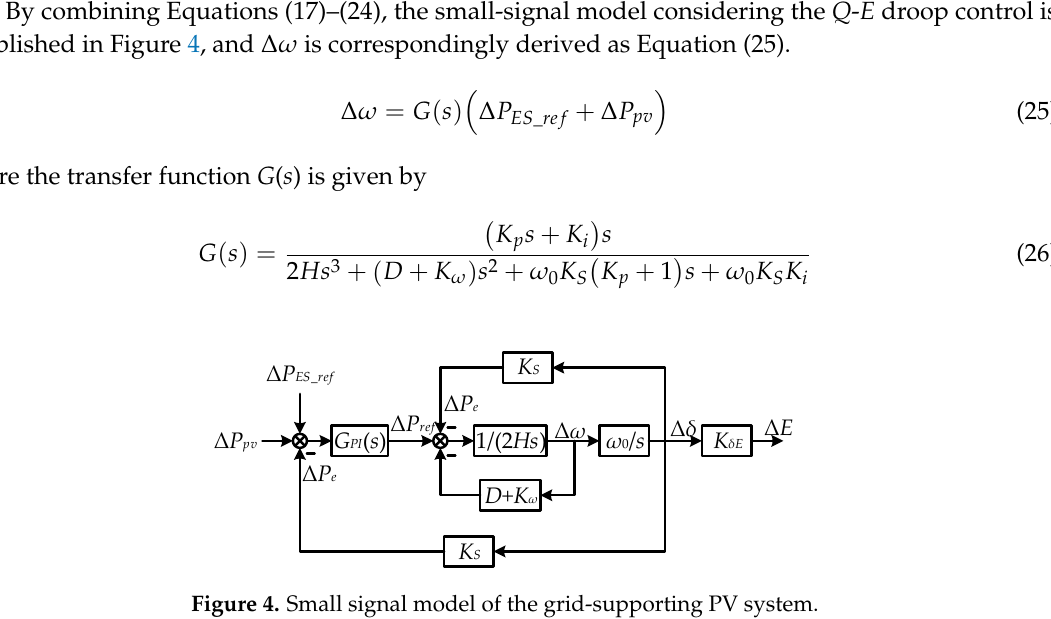
Figure 4. Small signal model of the grid-supporting PV system.